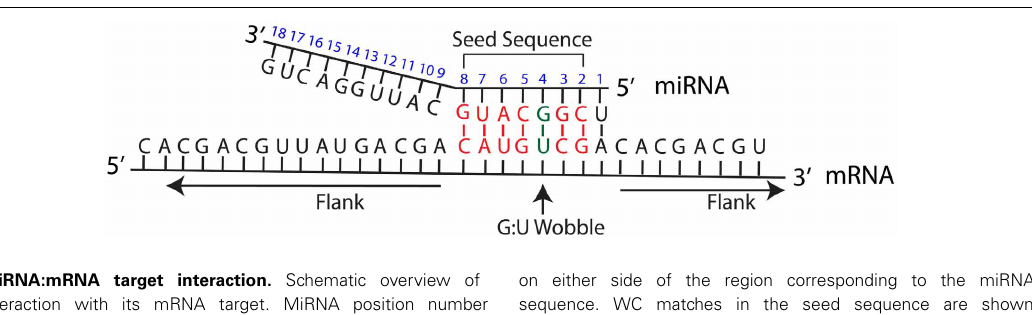
on either side of the region corresponding to the miRNA seed sequence. WC matches in the seed sequence are shown in red, and an example of G-U wobble in the seed sequence is shown in